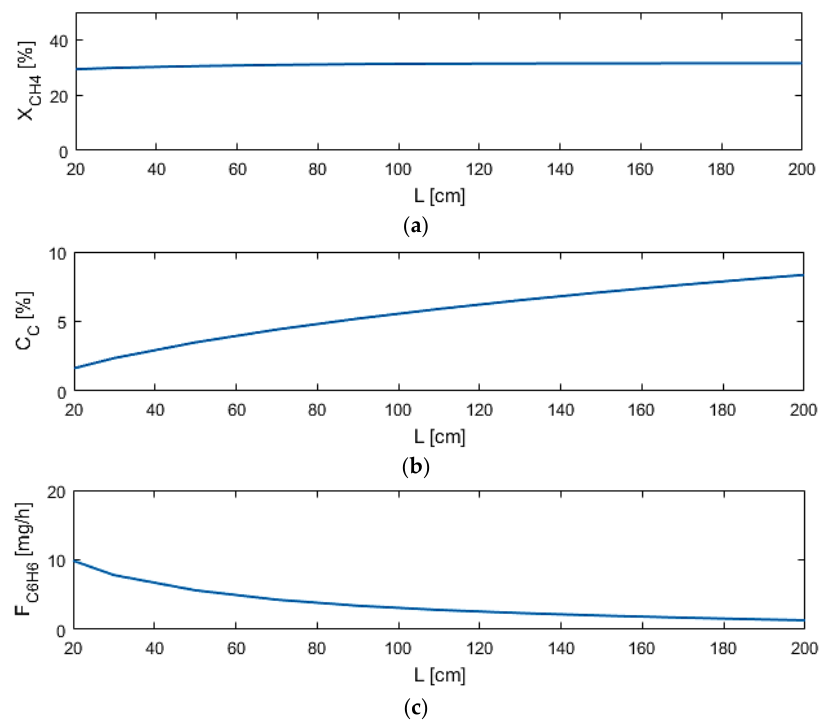
Figure 7. Sensitivity studies of L for model performance criteria: ( a ) X CH4 ; ( b ) C C ; ( c ) F C6H6 .